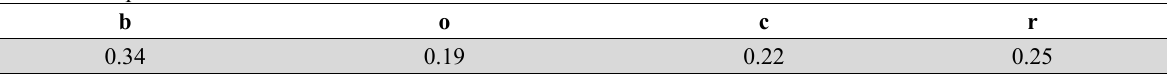
BOCR merits preferences. b o c r 0.34 0.19 0.22